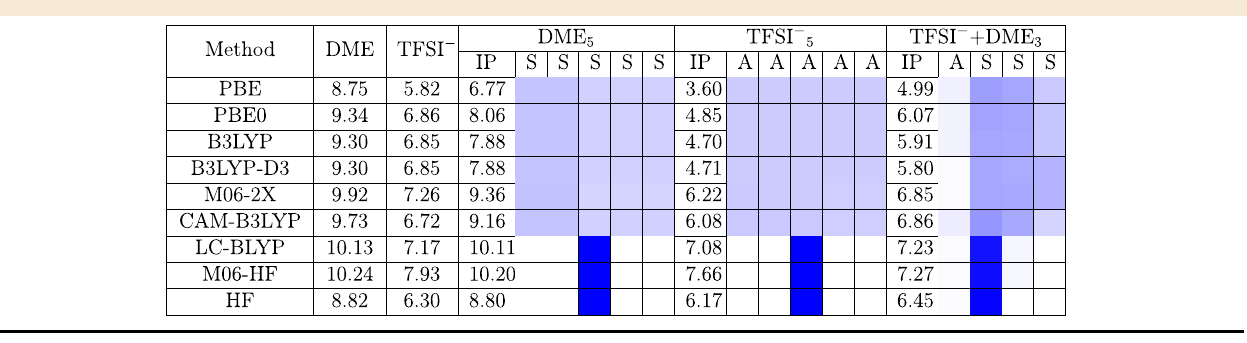
Table 1 Ionization potential (eV), and charge distribution for different systems computed in vacuum with different functionals